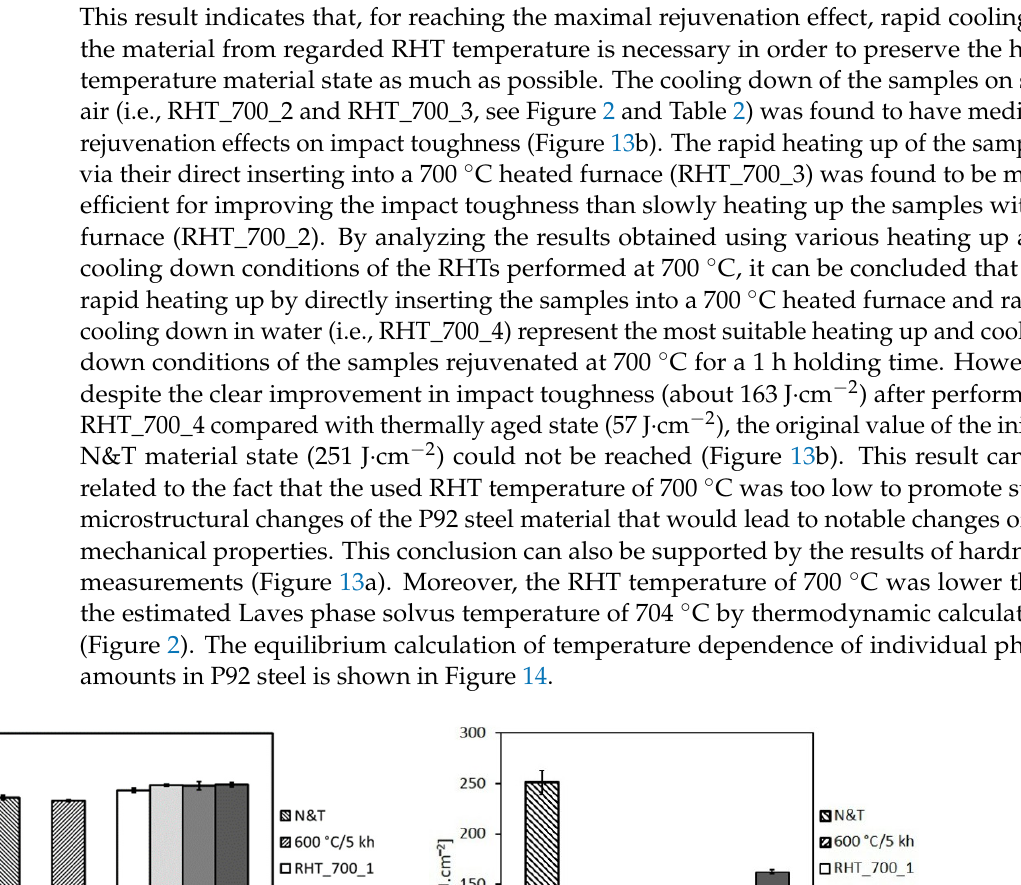
Figure 11. The effect of various heating up and cooling down conditions of the rejuvenation heat treatment at 700 °C for 1 h on ( a ) yield stress and ( b ) ultimate tensile strength.